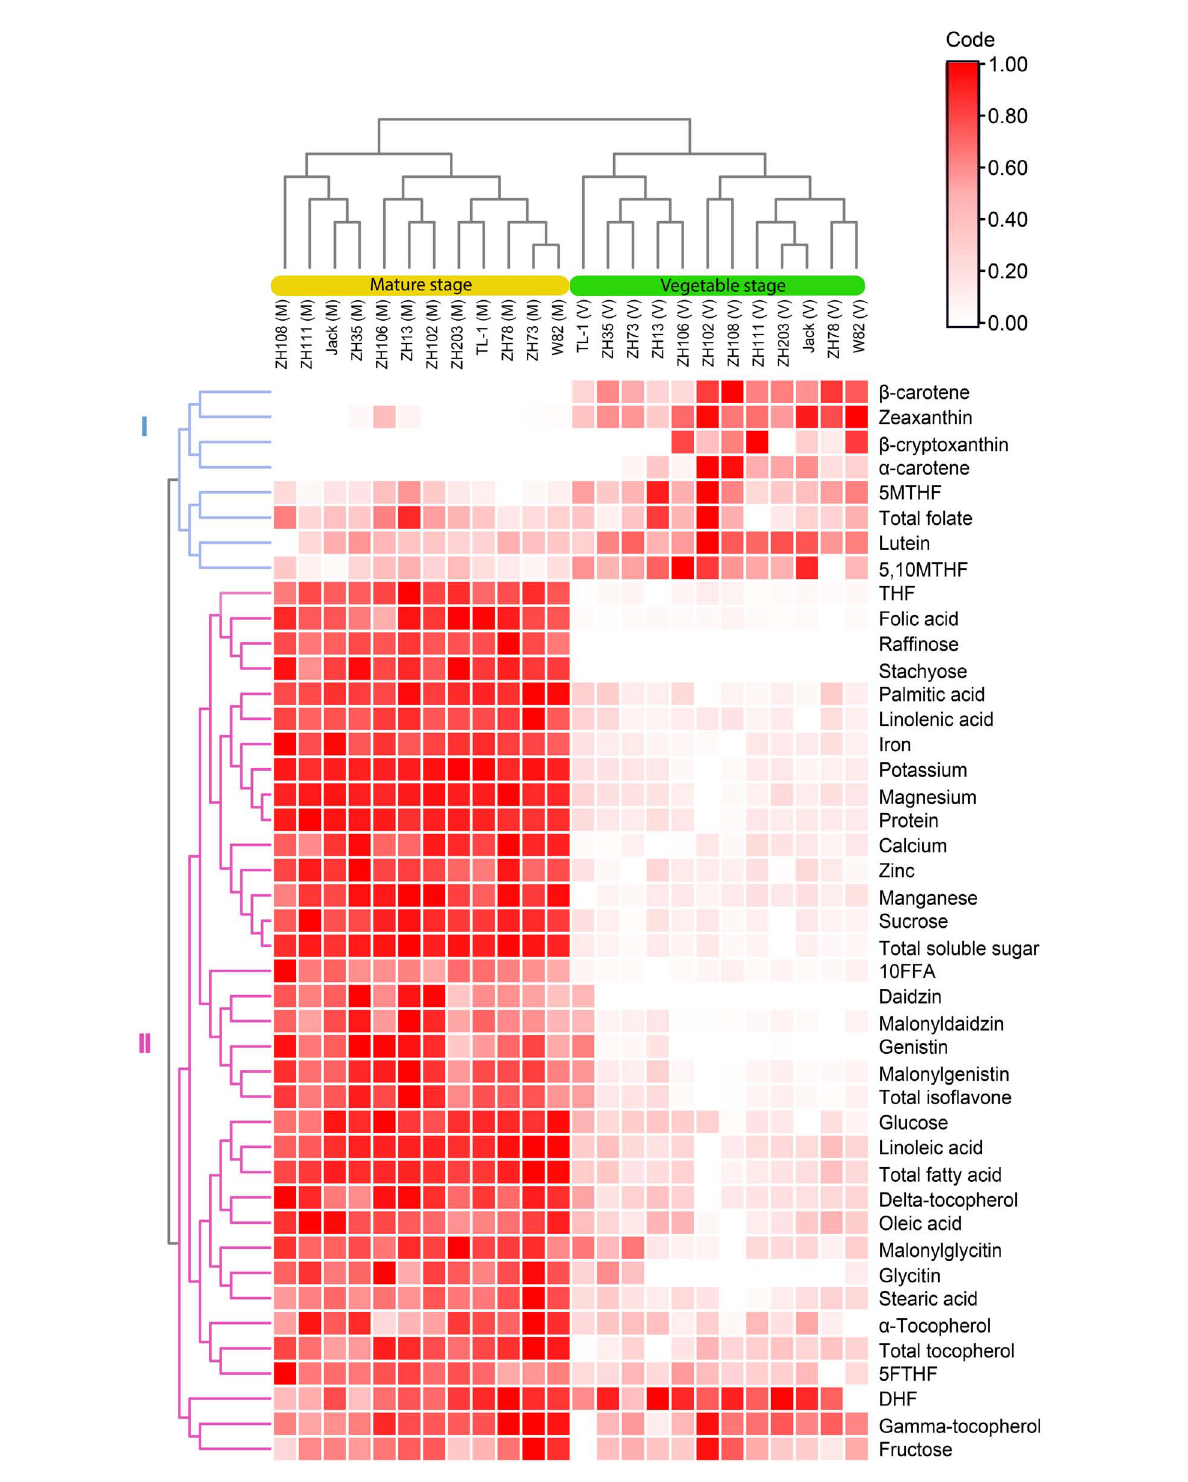
FIGURE6 Hierarchical clustering and heatmap of soybean cultivars and quality traits (FW) at the vegetable and mature stages.